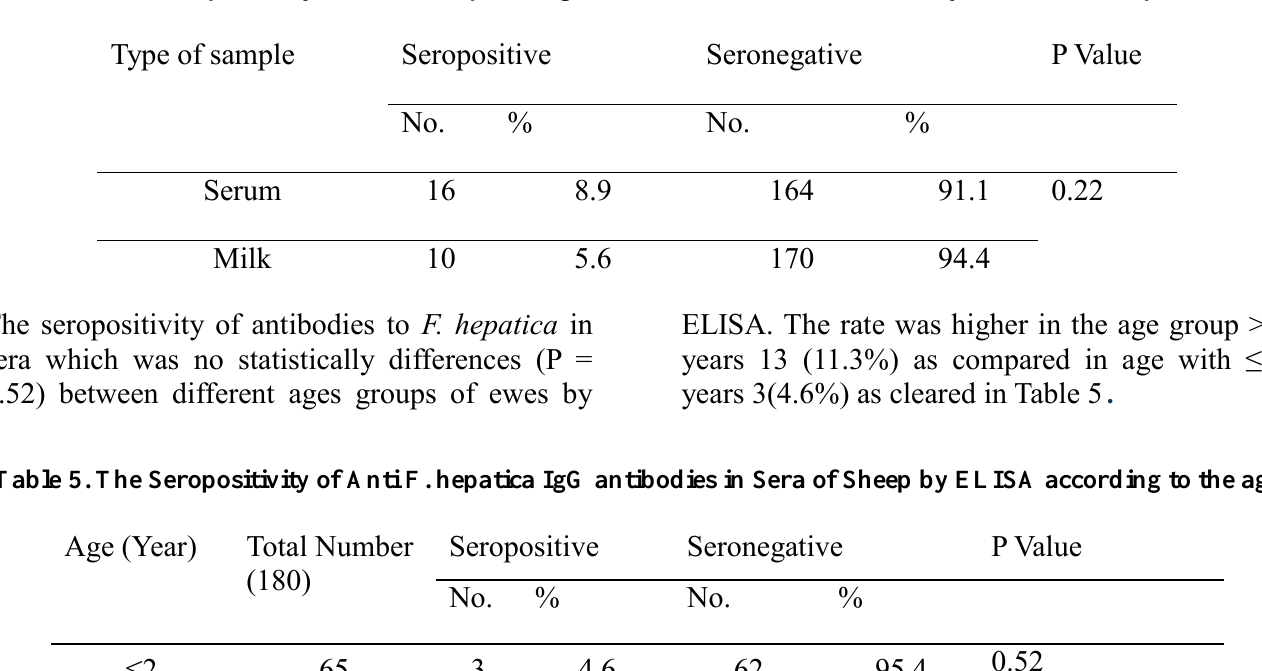
Table 4. The Seropositivity of Anti F. hepatica IgG antibodies in Sera and Milk by ELISA in Sheep (No=180)